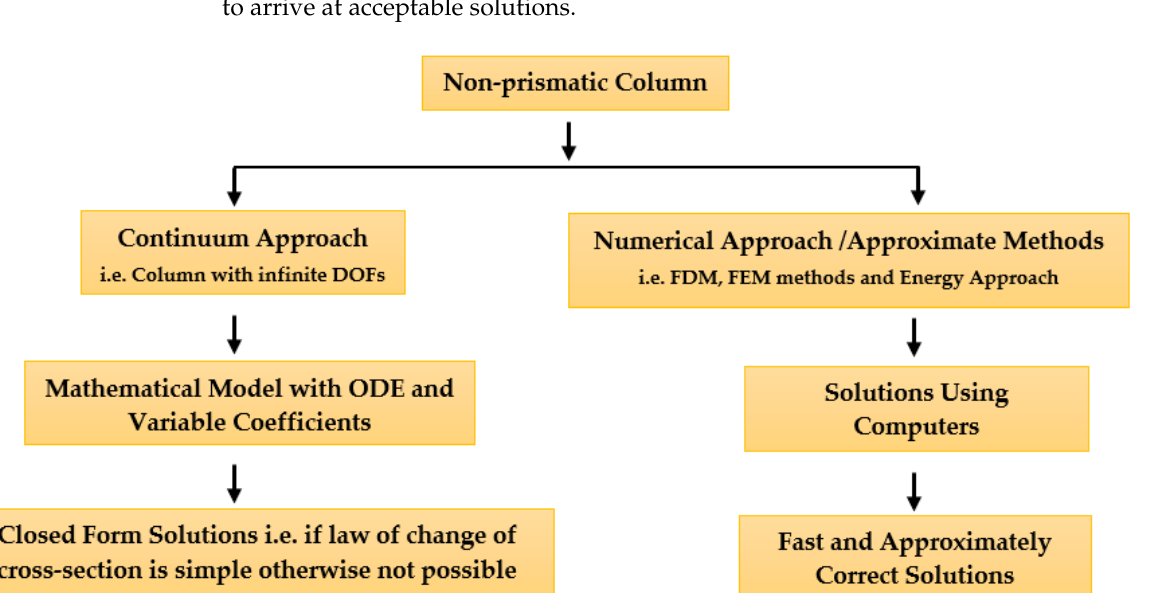
Figure 6. Approaches for the solution of nonprismatic columns. Table 1. Summary of research on nonprismatic columns using continuum or numerical approaches. Ref.